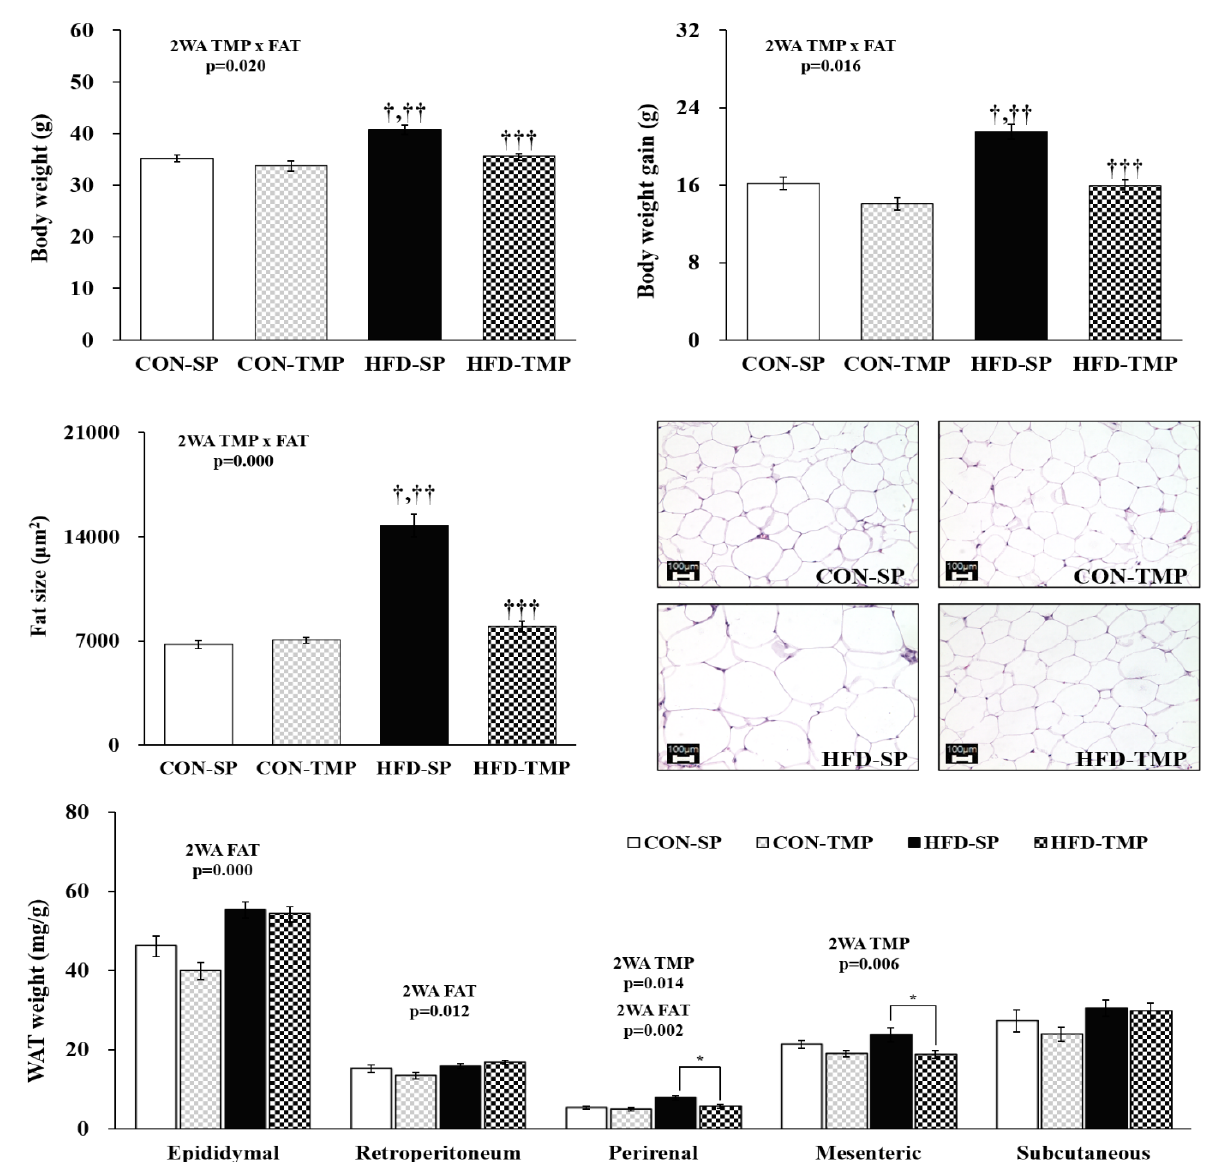
Figure 1. Body weight, body weight gain, fat mass, and adipocyte size. The values are expressed as the means ± S.E. (n = 10 per group). † vs. CON-SP, †† vs. CON-TMP and ††† vs. HFD-SP by two-way ANOVA followed by a Turkey post hoc test ( p < 0.05). * p < 0.05 vs. HFD-SP by Student’s t -test. Histological analysis magnification 200 × . 2WA FAT, fat diet effect in two-way ANOVA ( p < 0.05); 2WA TMP, TMP effect in two-way ANOVA ( p < 0.05); 2WA TMP × FAT, interaction between TMP and fat diet in two-way ANOVA ( p < 0.05); CON-SP, control diet containing SP; CON-TMP, control diet containing TMP; HFD-SP, high-fat diet containing SP; HFD-TMP, high-fat diet containing TMP.